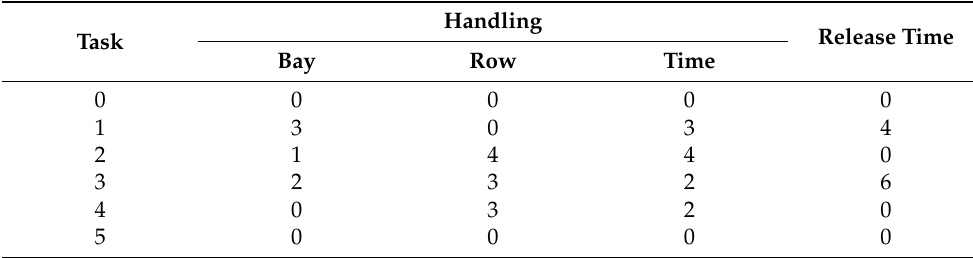
Table 1. An example of initial task .